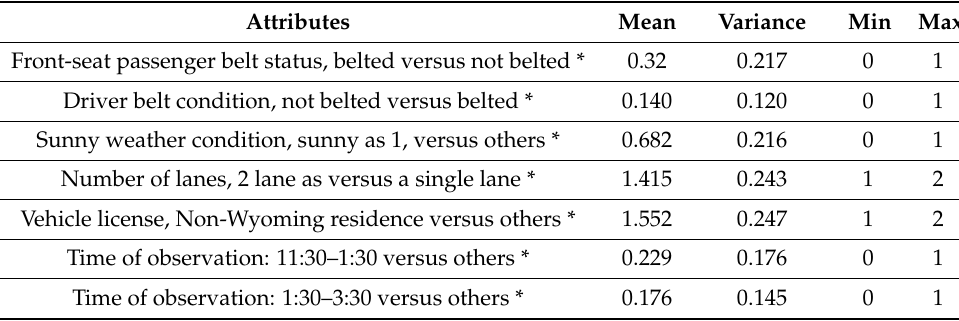
Table 1. Descriptive summary of important